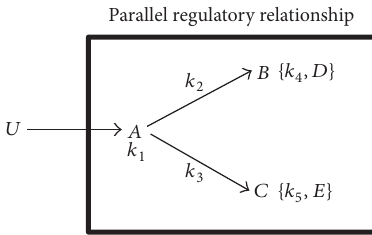
Figure 3: Parameters representing regulatory relationships between three genes ( 𝐴 , 𝐵 , and 𝐶 ) are given in (1), (2), and (3). Parameters representing the magnitude of regulation of one gene by another ( 𝑘 2 ,𝑘 3 ) are shown over the edge connecting the genes. Rate of degradation of mRNA produced by genes is given within {} ( {𝑘 4 , 𝐷} and {𝑘 5 ,𝐸} ) or below the names of genes ( 𝑘 1 ). 𝑈 represents an external input regulating expression of genes within the